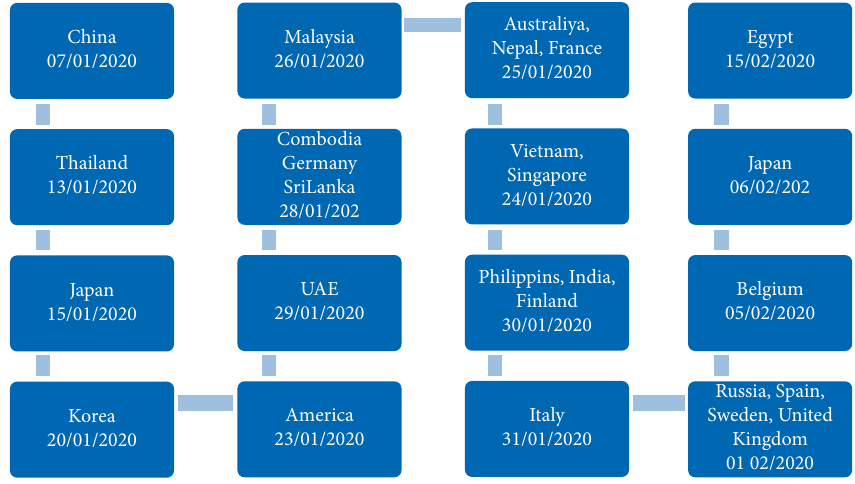
Figure 3: History of the origin and spread of COVID-19 infection globally